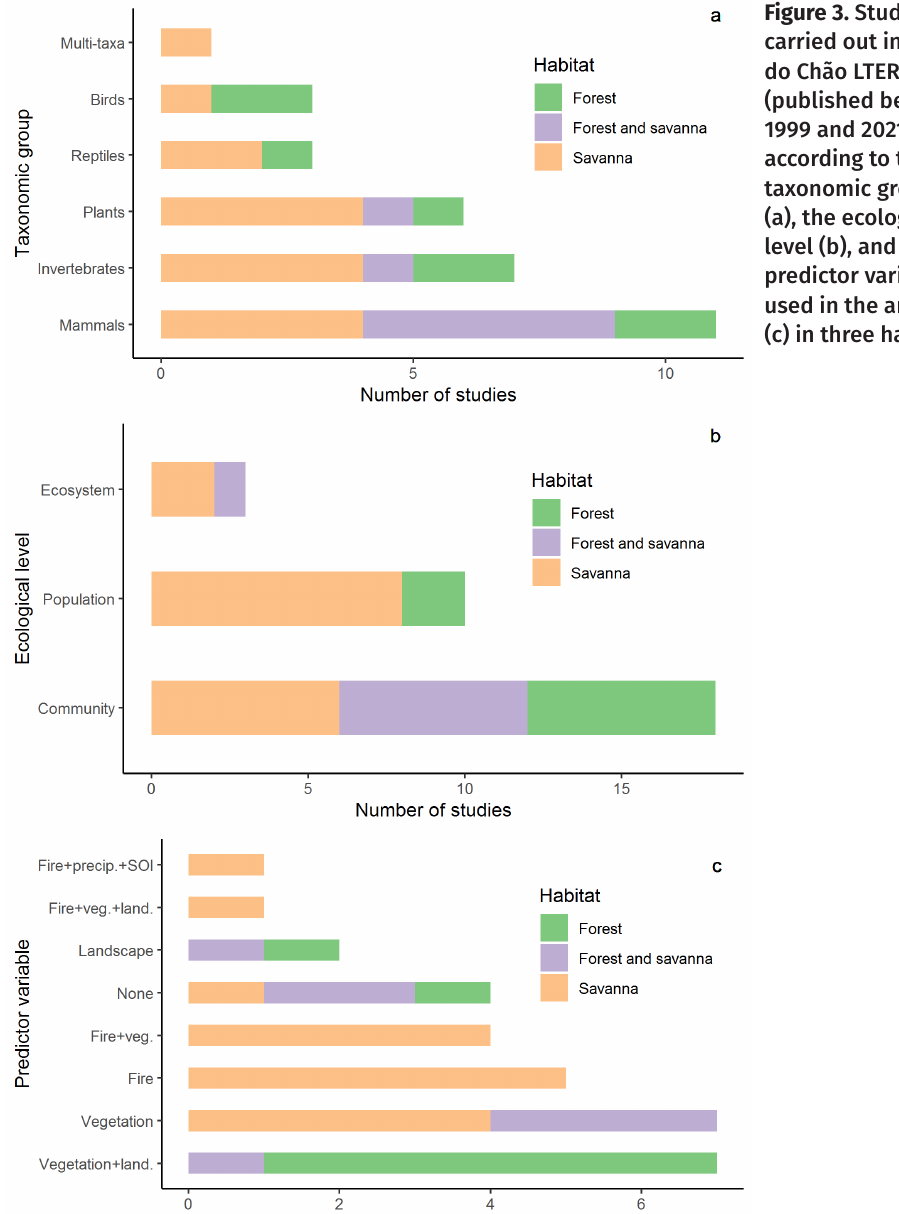
Figure 3. Studies carried out in Alter do Chão LTER